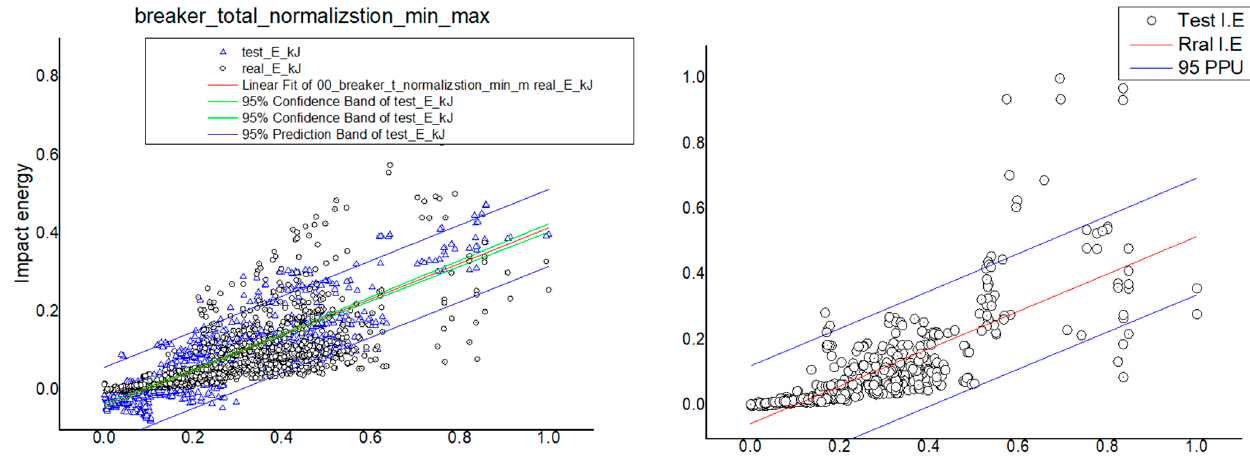
( b ) The 95% of projected uncertainties (95PPU) for the NNMM model. Figure 8. A neural network regression test result diagram. Confidence interval calculation of best diagram and projected uncertainties (95 PPU ) for NN–MM model: ( a ) Confidence interval calculation of best model; ( b ) 95% of projected uncertainties (95 PPU ) for the NN–MM model.